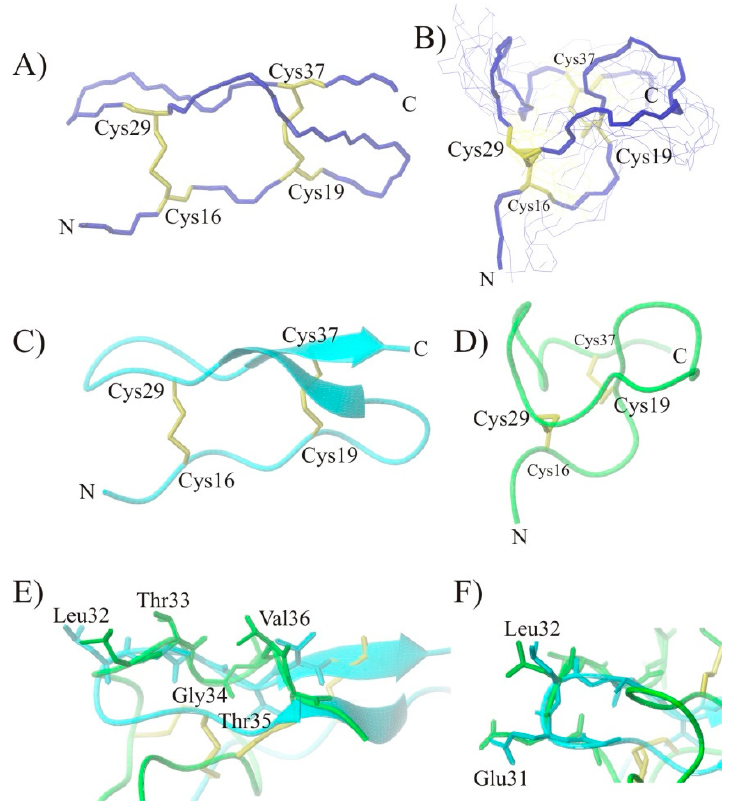
Figure 3. Panel A shows the spatial structure of the herpes virus entry mediator protein fragment (14–39) (PDB code: 2AW2). Panel B shows superimposed NMR conformations of all α C atoms of the HVEM (14–39) peptide (RMSD = 1.947 Å). The last structure from the MD has been emboldened. Panel C shows the structure of fragment 14–39 from the HVEM protein (PDB code: 2AW2) (cyan color), and panel D shows the NMR structure of the HVEM (14–39) peptide (green color) after MD calculations. Panel E shows the structure of fragment 32–36 from the HVEM protein (PDB code: 2AW2) (cyan color) with the NMR structure of the HVEM (14–39) peptide (green color) superimposed. The side chains of amino acid residues important for interaction with the BTLA protein are highlighted in the figure. Panel F shows the amino acid residues forming the bend. The structures are shown as a backbone ( A , B ), ribbon ( C – F ), or stick ( E , F ) representation; the cysteine side chains are shown in the stick representation. Disulfide bonds are shown in yellow.